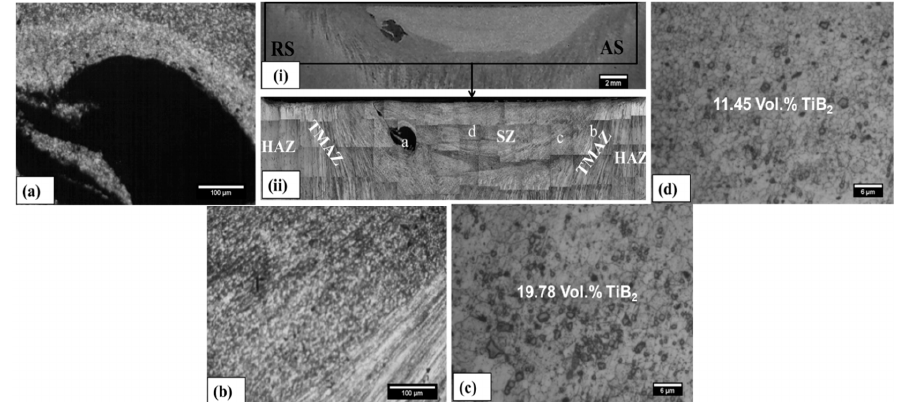
Figure 12. ( i ) Macro-image of cross-section of Sample 6. ( ii ) Microstructure of cross-section of the rectangle in macro-image showing: ( a ) agglomerated region (particles washed out during grinding and etching); ( b ) AS reinforced zone interface; and ( c , d ) dispersed regions.